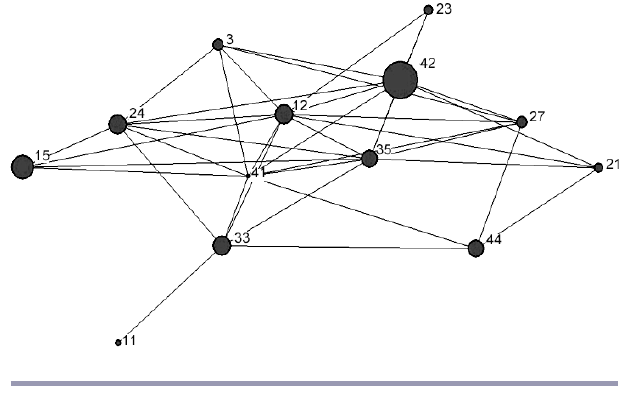
Fig. 5 . Working Group A (most functional). Nodes represent individual working group members. Node size represents the member’s in-degree centrality. A larger node indicates a higher in-degree centrality value for that member and, thus, more prominence within the network.